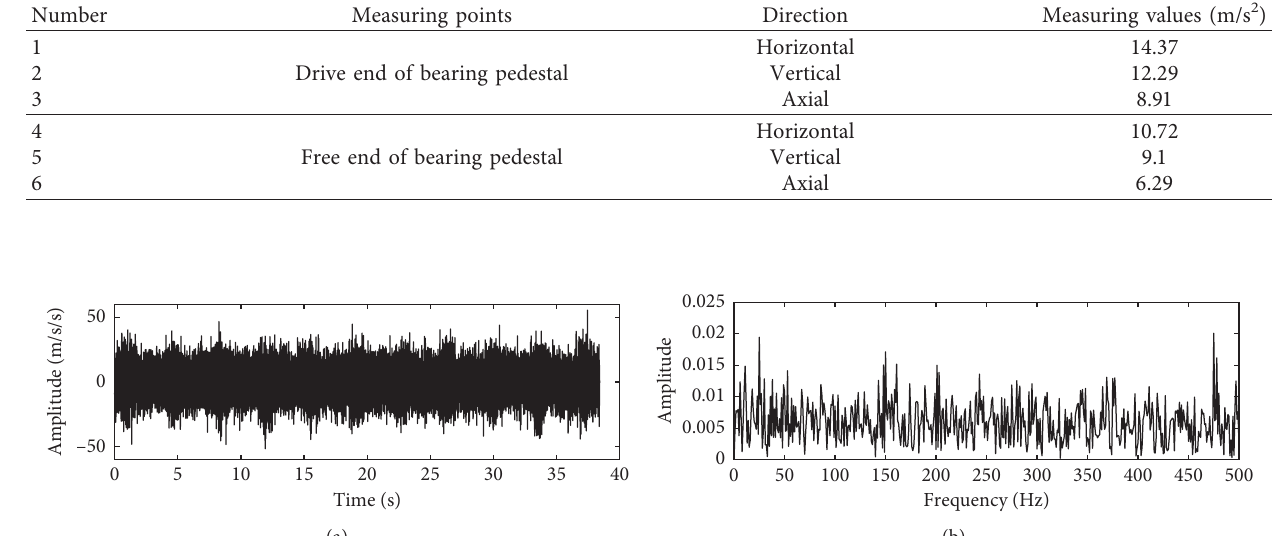
Table 2: Values of the measuring points.